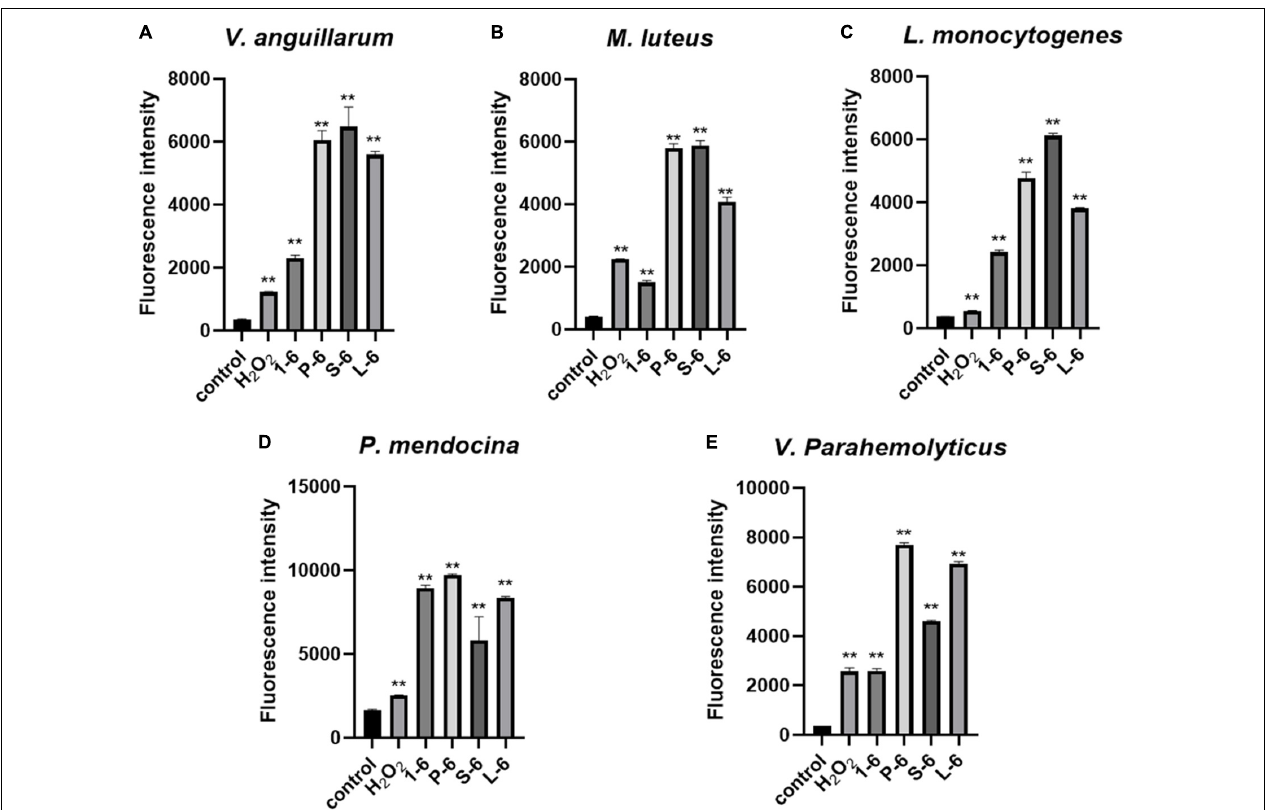
FIGURE 9 | Effects of 1–6, P-6, S-6, and L-6 on intracellular ROS levels. (A) V. anguillarum treated with 1–6, P-6, S-6, and L-6. (B) M. luteus treated with 1–6, P-6, S-6, and L-6. (C) L. monocytogenes treated with 1–6, P-6, S-6, and L-6. (D) P. mendocina treated with 1–6, P-6, S-6, and L-6. (E) V. parahaemolyticus treated with